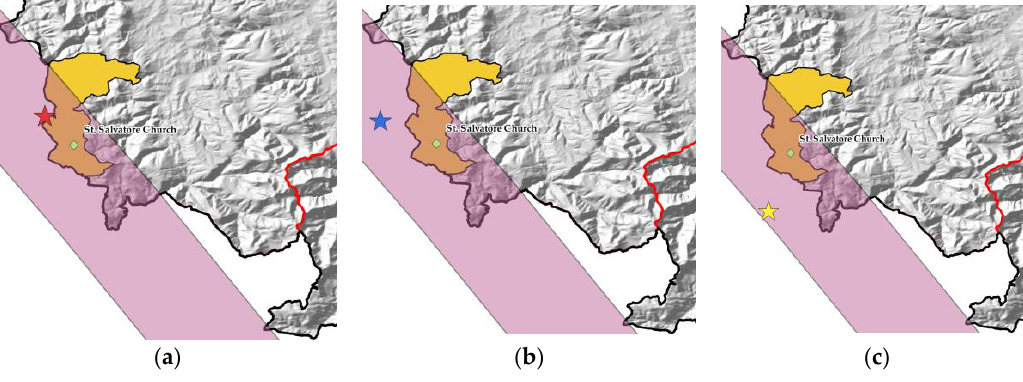
Figure 11. The 1997 major shocks with the location of St. Salvatore church (green square) in Acquapagana and the seismogenic fault system of Colfiorito (purple area). ( a ) The red star points out the epicenter of the 26 September 1997 event at 0:33 a.m. [53]; ( b ) the blue star specifies the epicenter of the 26 September 1997 event at 9:40 a.m. [54]; ( c ) the yellow star indicates the epicenter of the 14 October 1997 event [55].